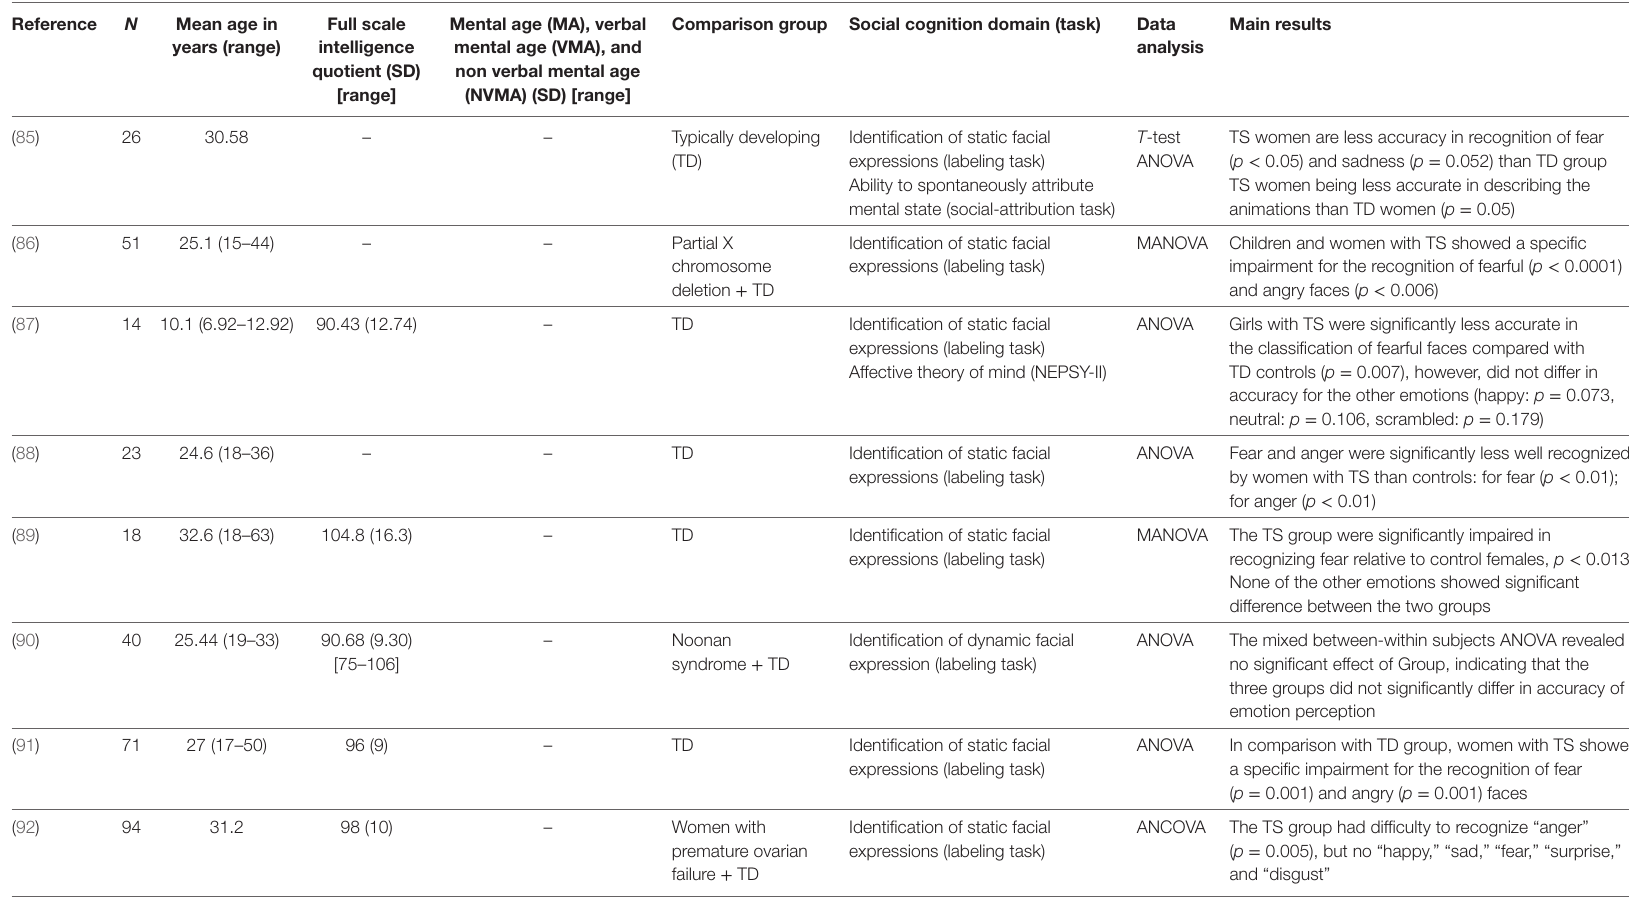
TAbLe 4 | Studies examining social cognition in Turner syndrome